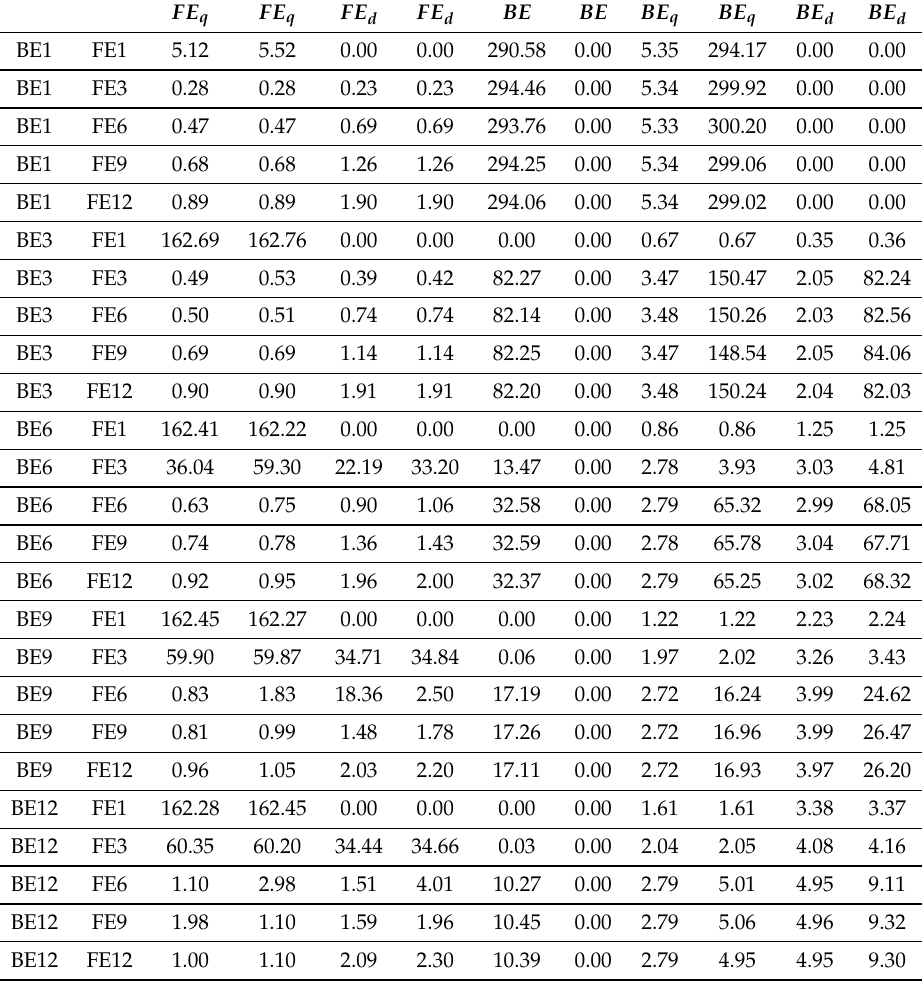
Table 4. Two cases in one table: 3000 threads per FE node, 40 database connections per BE node and 3000 threads per FE node, 4000 database connections per BE